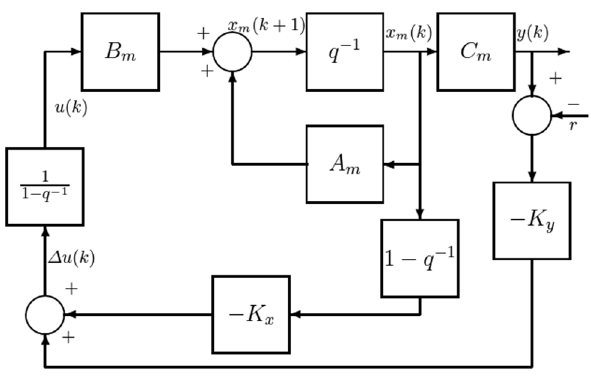
Figure 3: Closed - loop control system of MPC [ 5 ] .